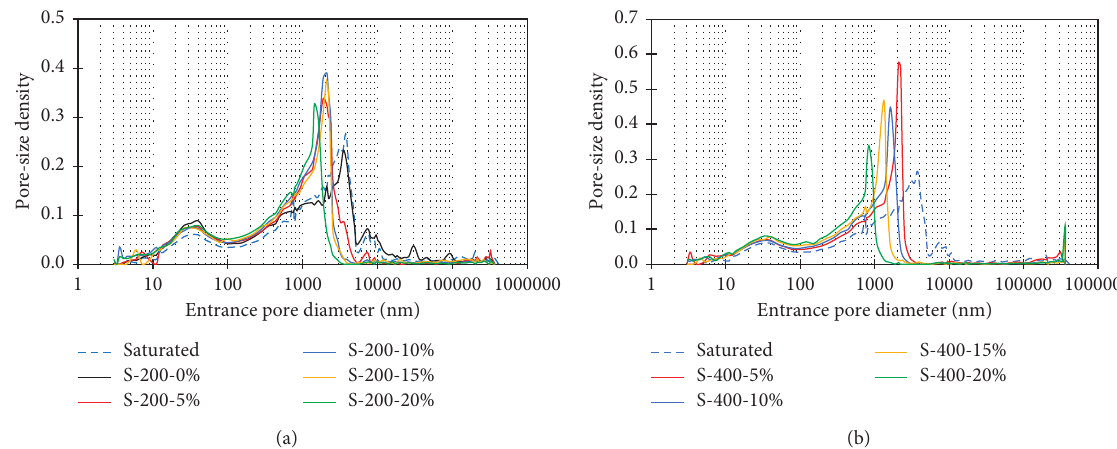
Figure 13: PSDs of saturated loess specimens sheared to sequential axial strains under the confining stress of (a) 200kPa and (b)